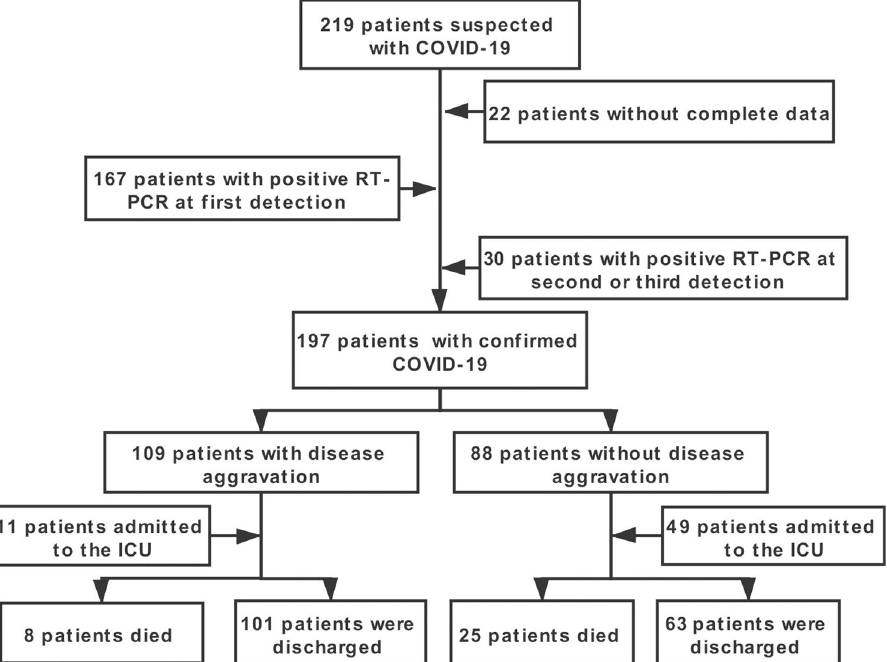
Figure 1. Study flow of patient selection, classification, identification and outcomes in our study.